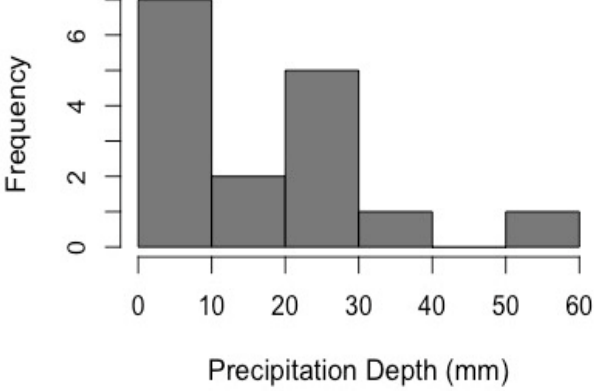
Figure 3. Distribution of storm event depths during the 2019 sampling season.